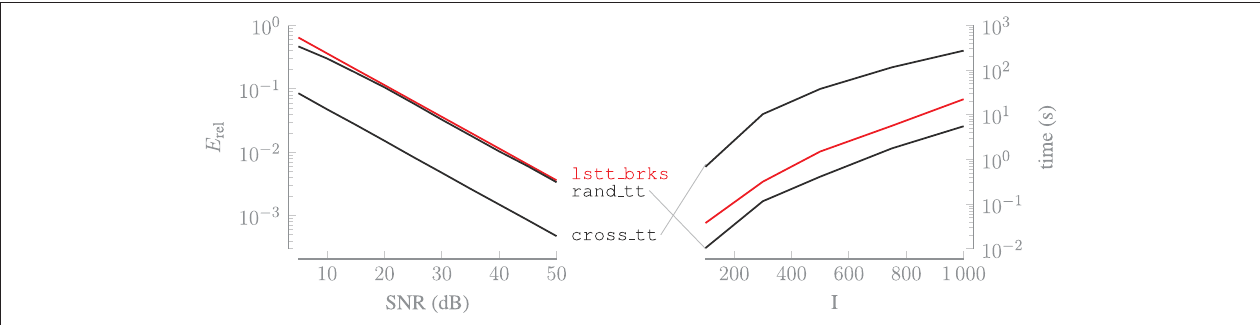
FIGURE 4 | Algorithm lstt_brks enables us to achieve accuracy similar to that of rand_tt in CS applications. If a method for obtaining any entry of X is available, then cross_tt can be used to recover a more accurate approximation of the tensor, in exchange for a longer computation time.